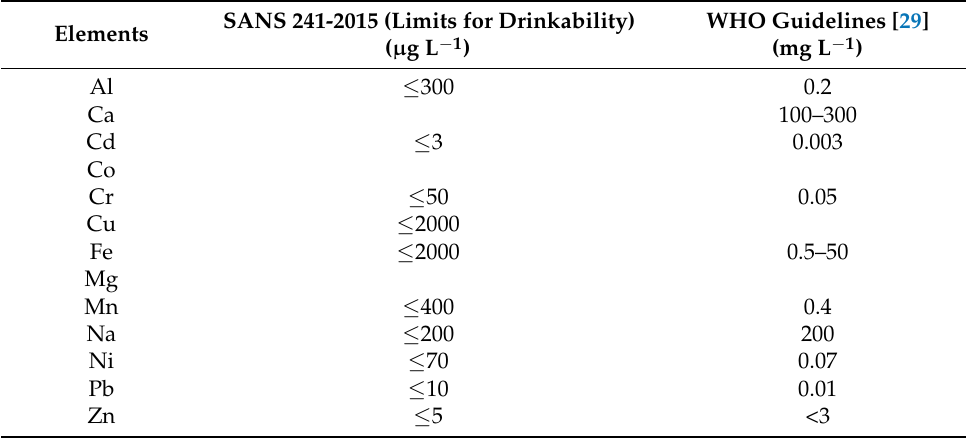
Table 2. SANS 241-2015 and WHO guidelines of drinking